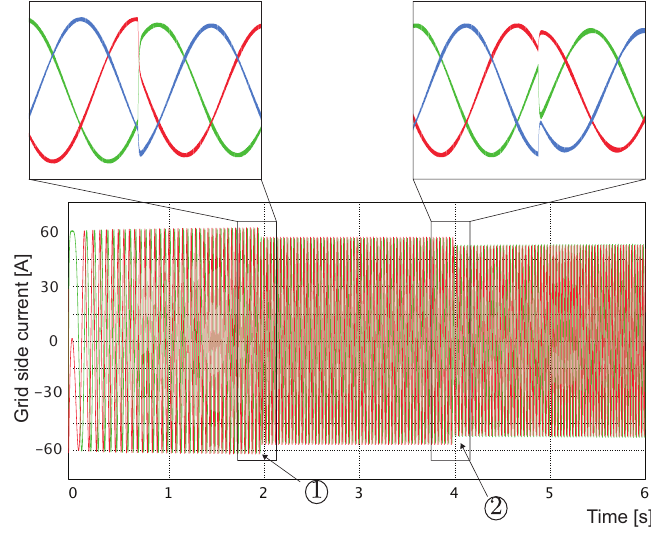
Figure 17. Grid side currents